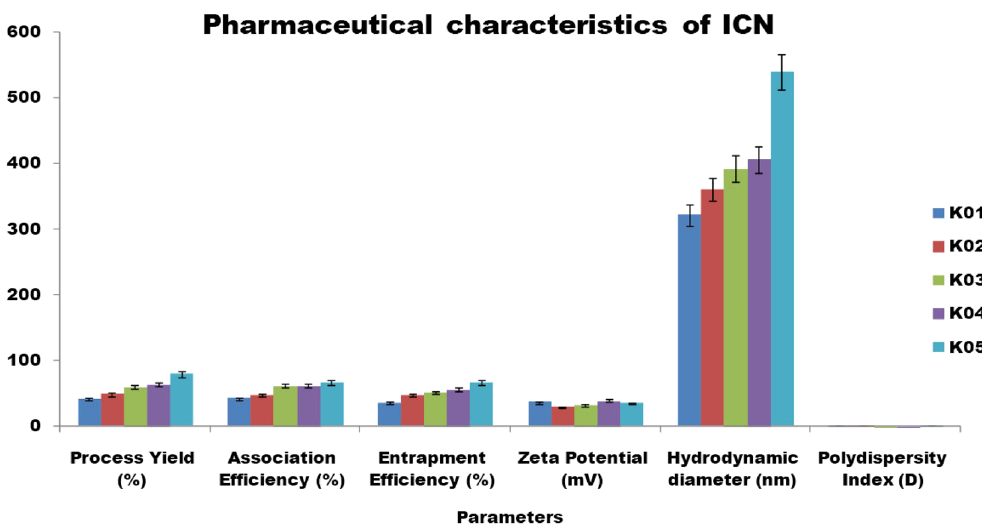
Figure 1. Statistical representation of pharmaceutical characteristics of